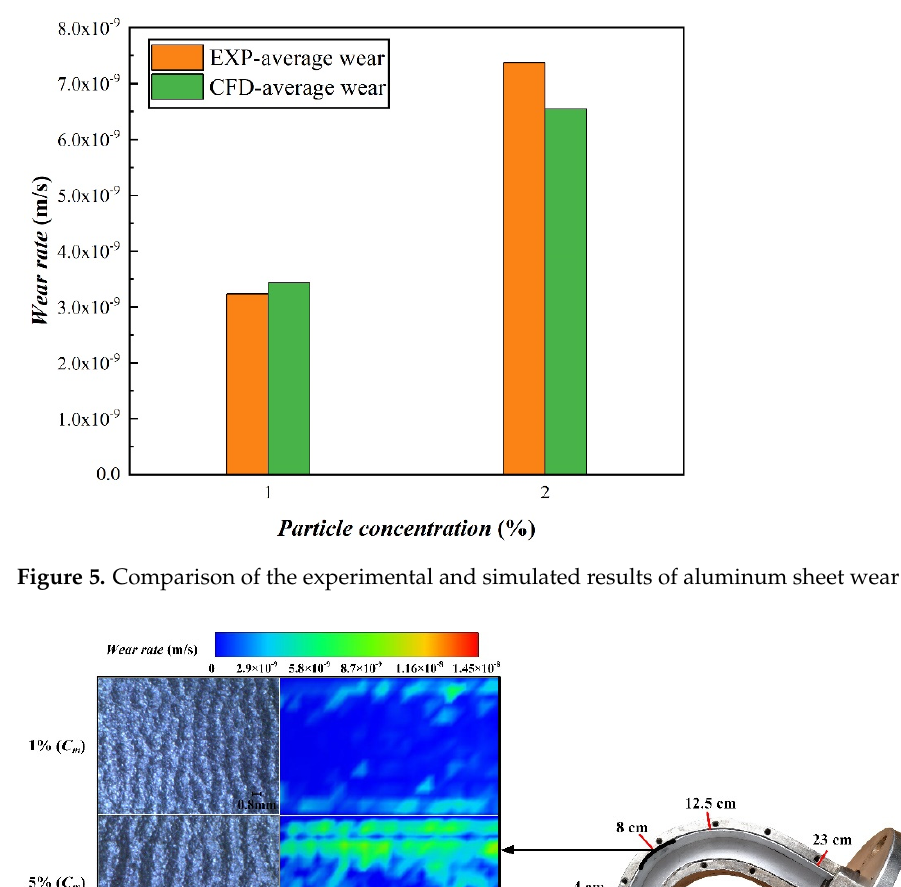
Figure 4. Schematic diagram of the experimental device.